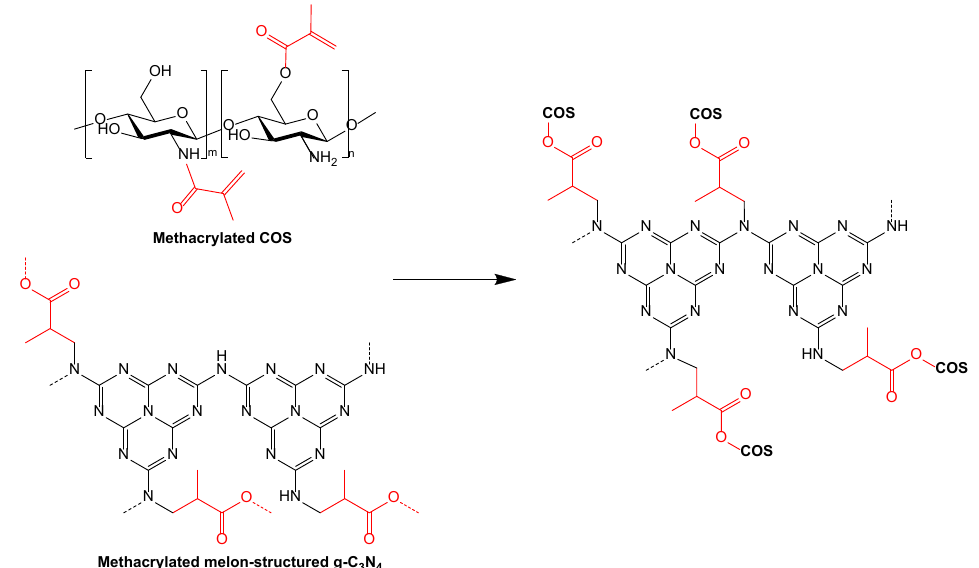
Figure 7. Hypothetical assembly of the methacrylated COS and methacrylated g-C 3 N 4 moieties.